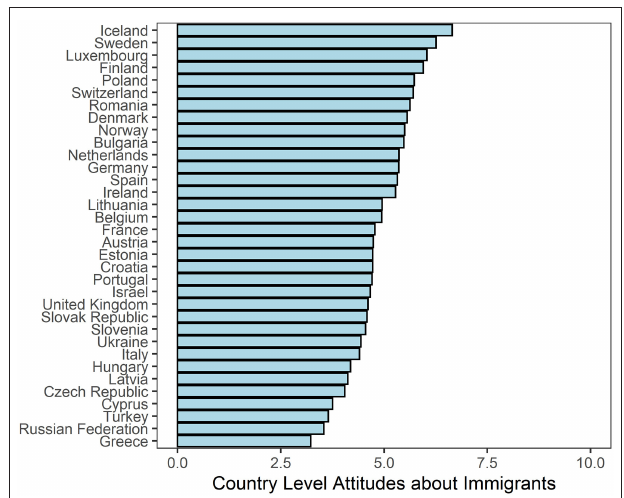
FIGURE 1 | Attitudes about immigrants, averaged across all